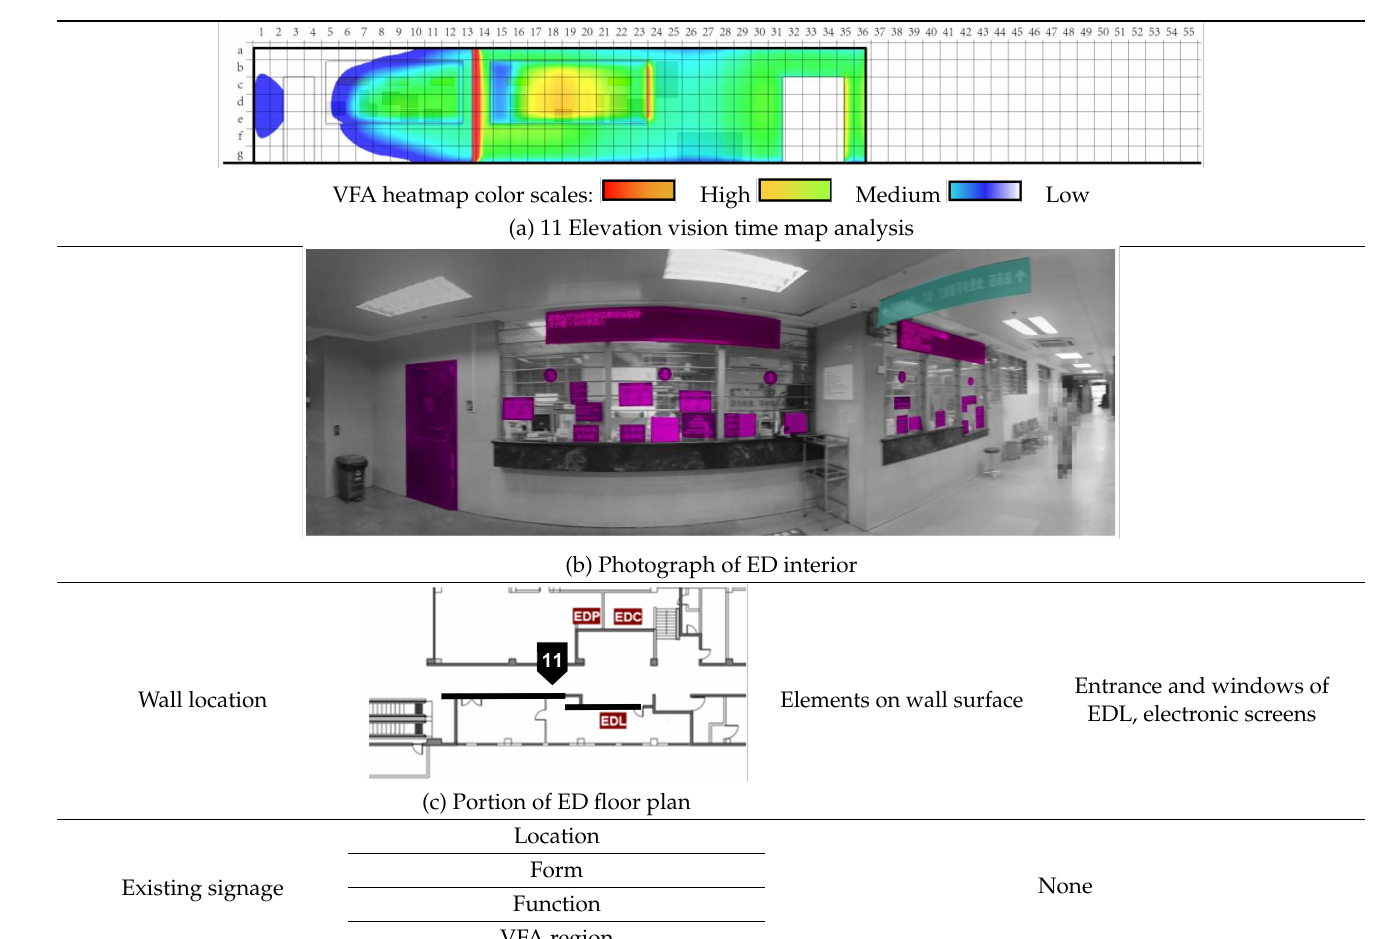
Table 15. 11 Elevation comparative